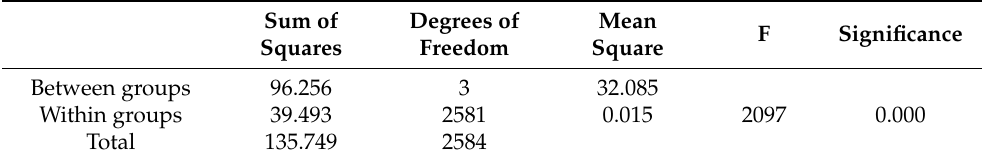
Table A1. Statistical analysis of ANOVA for the key wavelength of 715 nm for the four excess nitrogen